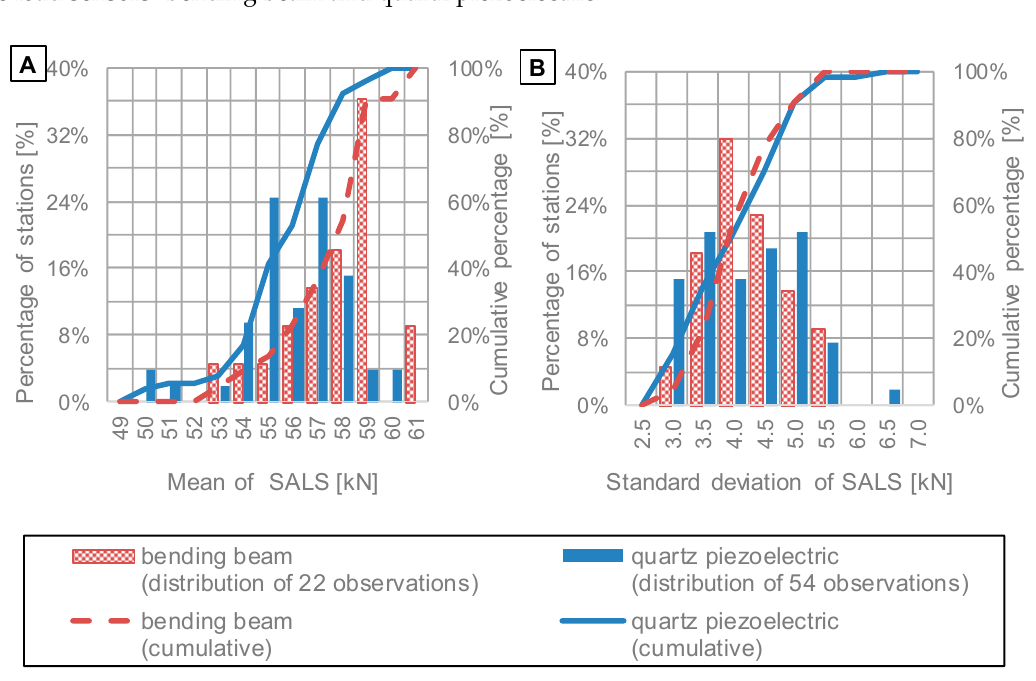
Figure 5. Distributions of ( A ) mean values of SALS and ( B ) standard deviations of SALS calculated on the basis of data from WIM systems equipped with bending beam or quartz piezoelectric axle load sensors.